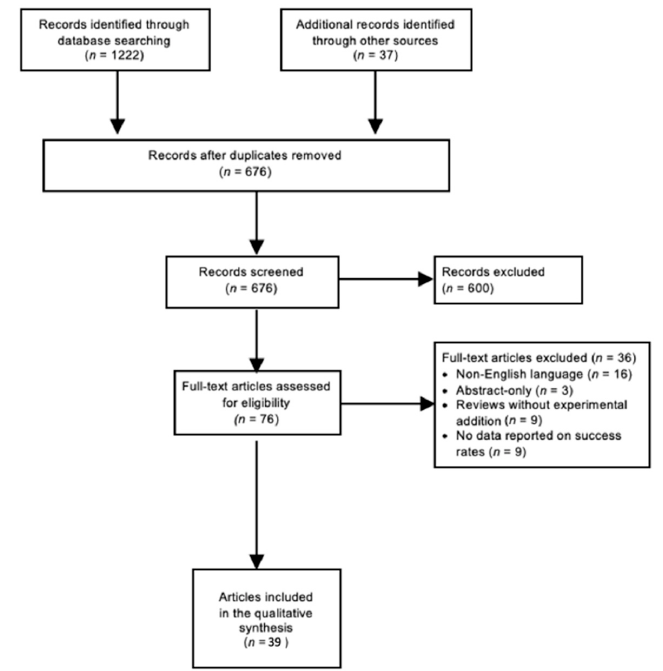
Figure 2. Literature search: PRISMA Consort flow diagram. According to THE PRISMA Statement 2009 [19]. Abbreviations: PRISMA = Preferred Reporting Items for Systematic Reviews and Meta- Analyses; n = amount of articles.